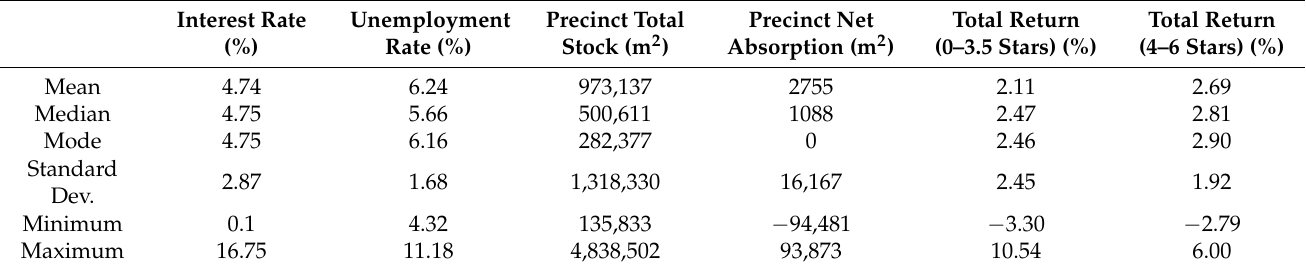
Table 10. Descriptive statistics of the regression variables.